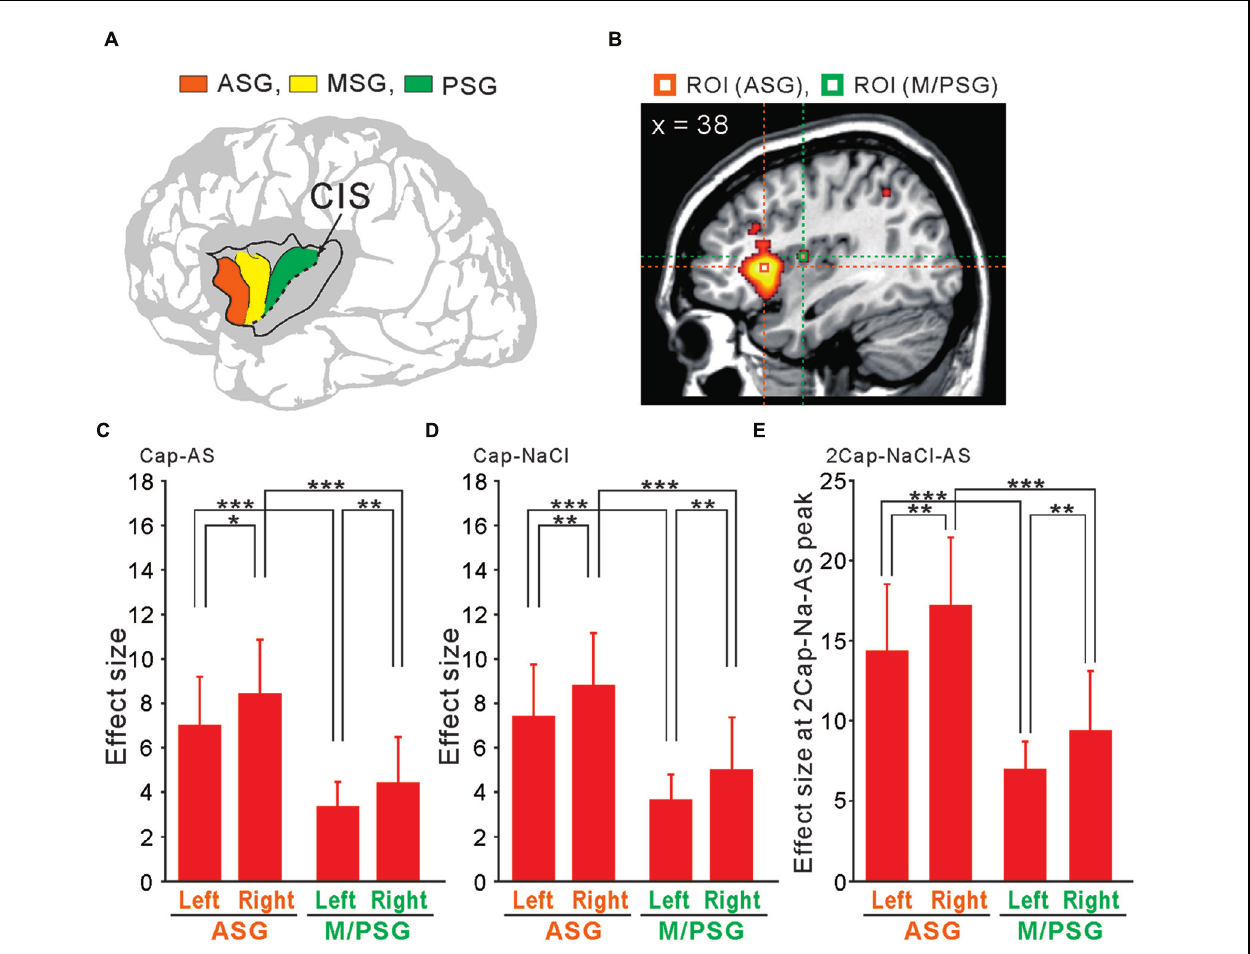
FIGURE 6 | ROI analysis using anatomically defined coordinates of the insular cortex. (A) The schema of three anterior short gyri. ASG, the anterior short gyri; MSG, the middle short gyri; PSG, the posterior short gyri. (B) Two ROIs located on a right sagittal view, which were at the peak coordinates in the right ASG and M/PSG of the comparison [2 × Capsaicin–NaCl–AS]. (C–E) The effect sizes at the bilateral ASG (orange) and M/PSG (green) of the three types of the comparisons; [Capsaicin–AS], [Capsaicin–NaCl], and [2 × Capsaicin–NaCl–AS]. ∗ p < 0.05; ∗∗ p < 0.01; ∗∗∗ p <